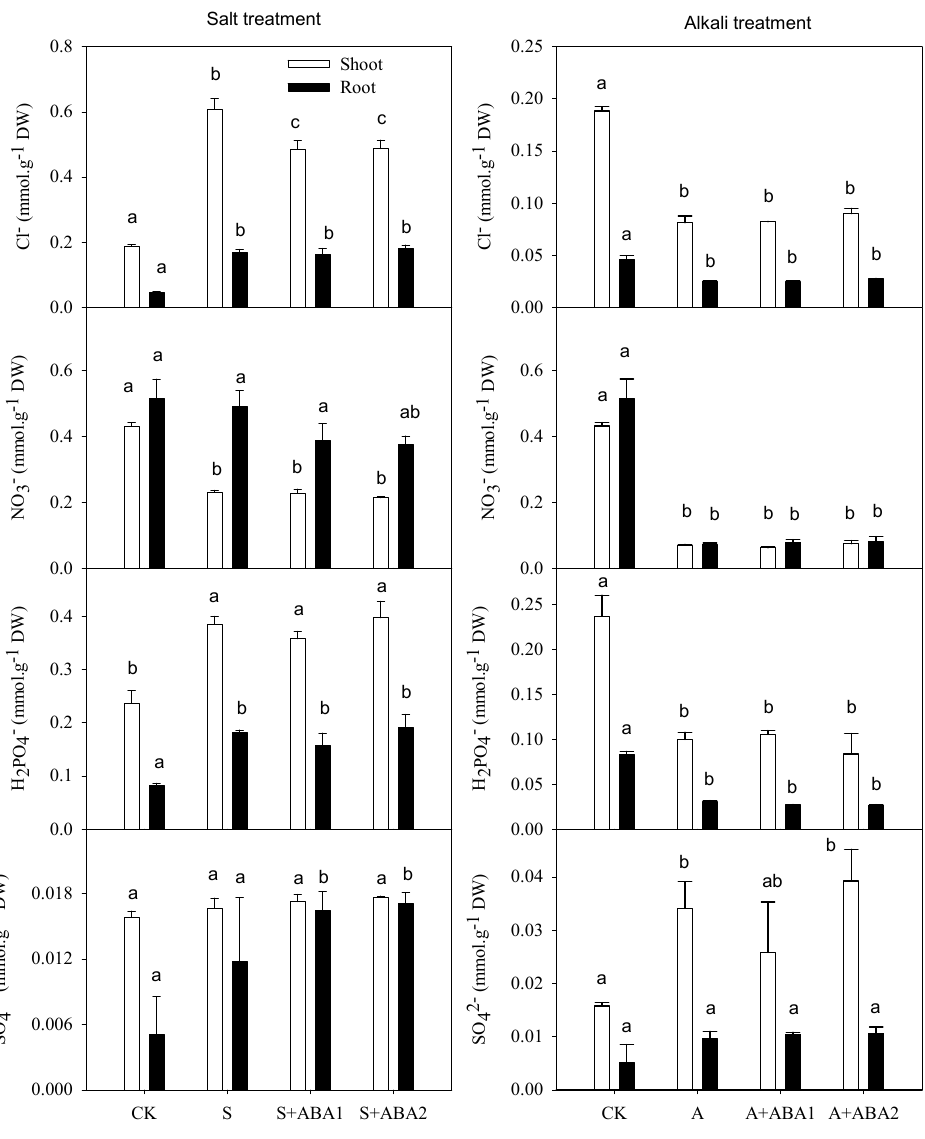
Figure 2. Effect of salt and alkali stress, with or without ABA treatment on the concentration of the main anions in shoots and roots. Means with different letters in columns with different colors are significantly different ( p < 0.05).